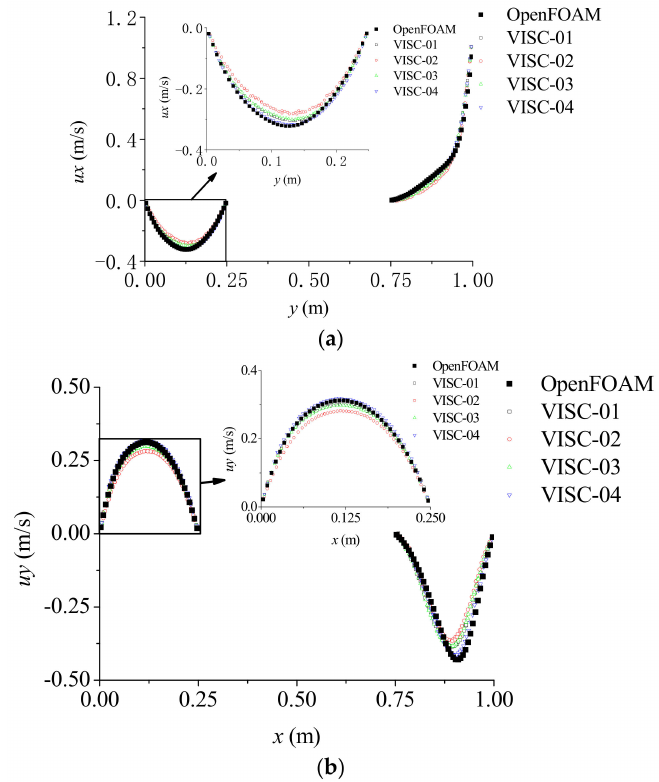
Figure 13. Comparisons of four viscosity force models for the lid-driven flow with an inside cylinder: ( a ) ux velocity distribution; and ( b ) uy velocity